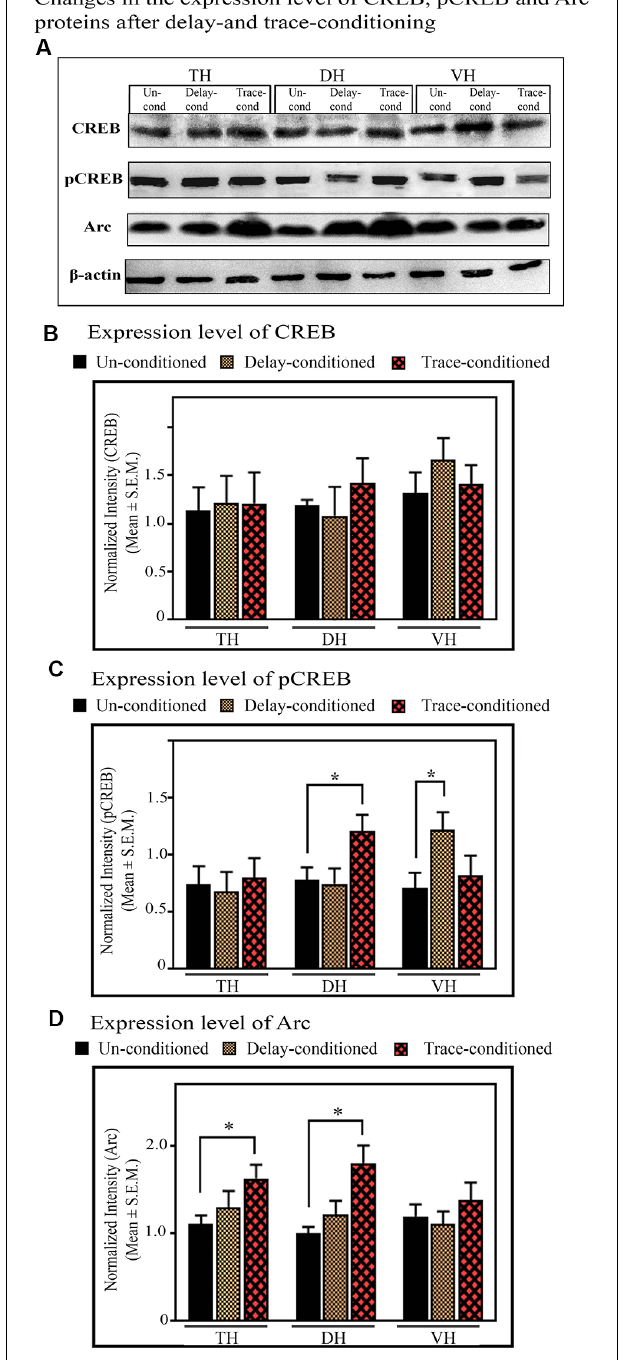
FIGURE 7 | The changes in the expression levels of CREB, pCREB, and Arc proteins after trace- and delay-conditioning in the total hippocampus (TH), DH, and VH. (A) Immunoblots showing bands of CREB, pCREB, Arc, and β -actin (loading control) in the TH, DH, and VH. The same β -actin blot, as is represented in Figure 6 is shown here for comparison. (B) The expression level of CREB was comparable in the un-conditioned control group ( n = 6), trace- ( n = 6), and delay- ( n = 6) conditioned group in TH,